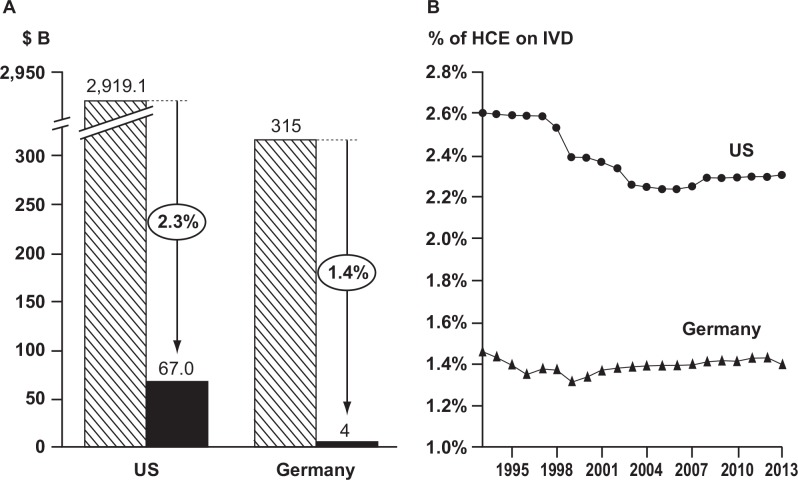
(A) Percentage of HCE on IVD in 2013 and (B) evolution of HCE on IVD 1993–2013. HCE, healthcare expenditure; IVD, in vitro diagnostics; $ B, US$ billion.